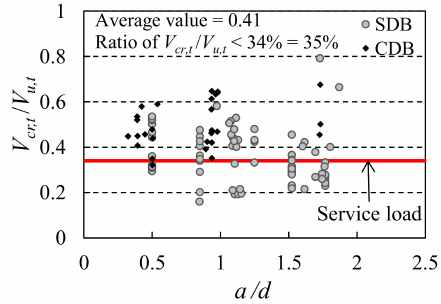
Figure 7. Ratios of diagonal cracking-to-ultimate shear strength according to shear span-to-effective depth ratio a / d